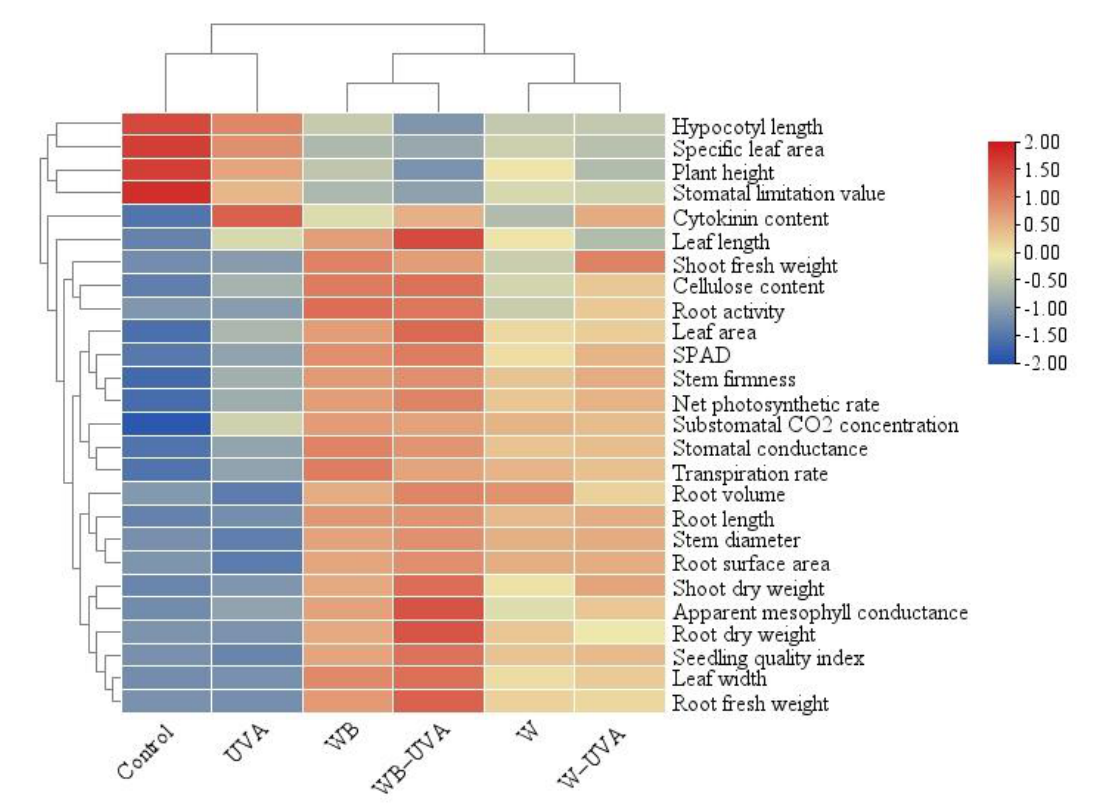
Figure 5. Cluster heat map analysis of greenhouse-grown cucumber seedlings for 22 days after sowing as influenced by white (W), UV-A light-emitting diodes (LEDs), and various combinations of W, blue (B), and UV-A LEDs. Blue and pure red indicated an increase and a decrease in the response parameters, respectively.